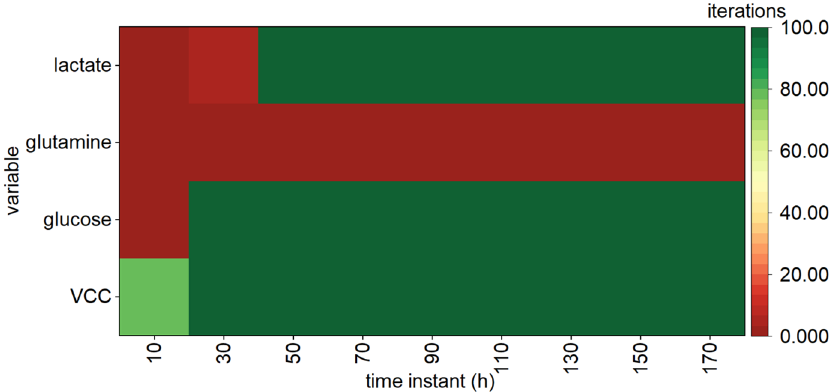
Figure 8. Process understanding for mAbs titer estimation through MPLS variable importance at each time point selection frequency: MPLS model calibrated with 8 process batches, randomly extracted from a subset of 10 batches contained in X PC and y , and 80 FPDM in silico generated batches from X FPD and y . FP